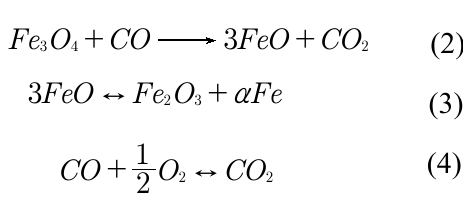
and chemically adsorbed (5.6%) oleic acid, respectively, on the surface of the nanoparticles 5,19 . These layers represent 0.045 and 0.115 mL of oleic acid adsorbed physically and chemically, respectively, for each gram of magnetic nanoparticles. The third stage of weight loss is above 450 ºC – 500 ºC. According to Ayyappan at al. 35